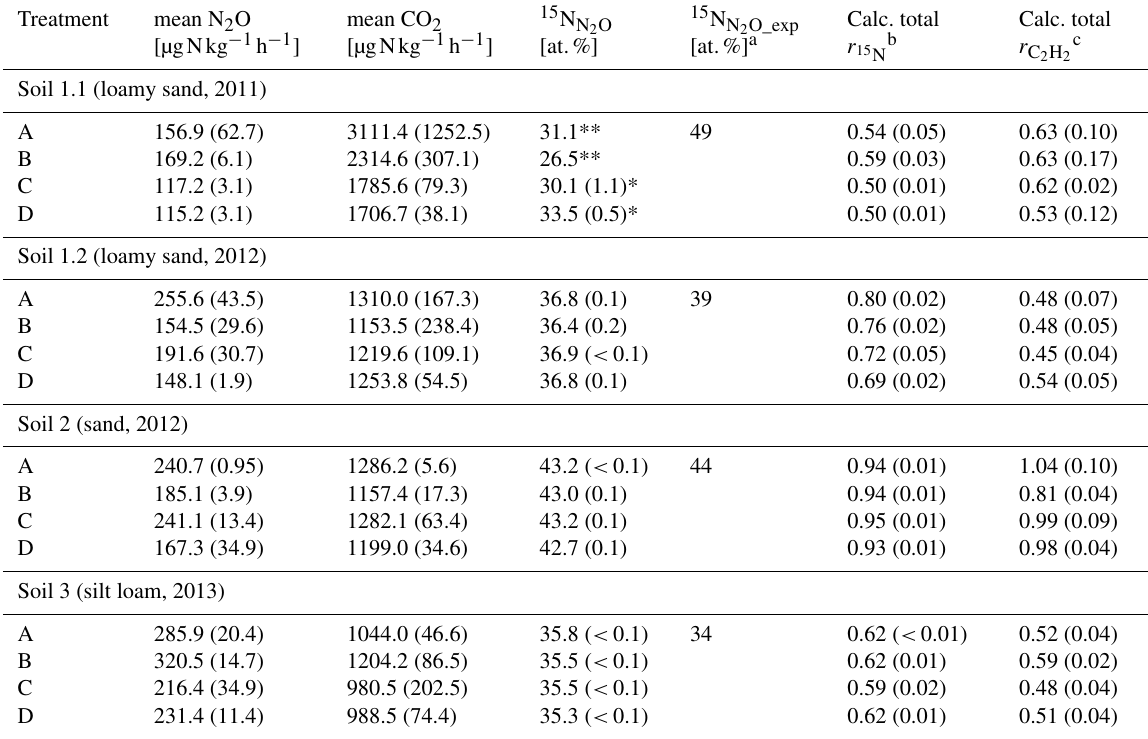
Table 3. Average CO 2 and N 2 O production rates of the last sample collection after 10 or 8h of variant traced, respectively, with 15 N labelling calculated from N 2 O production rates of variant − C 2 H 2 and + C 2 H 2 in N 2 O ( 15 N N ) and the calculated r 15 of variant traced and r C N 2 O 2 H 2 of each soil (Soil 1 to 3) for treatments A without growth inhibition, B with bacterial growth inhibition, C with fungal growth inhibition, and D with bacterial and fungal growth inhibition, respectively (standard deviation in brackets; n =